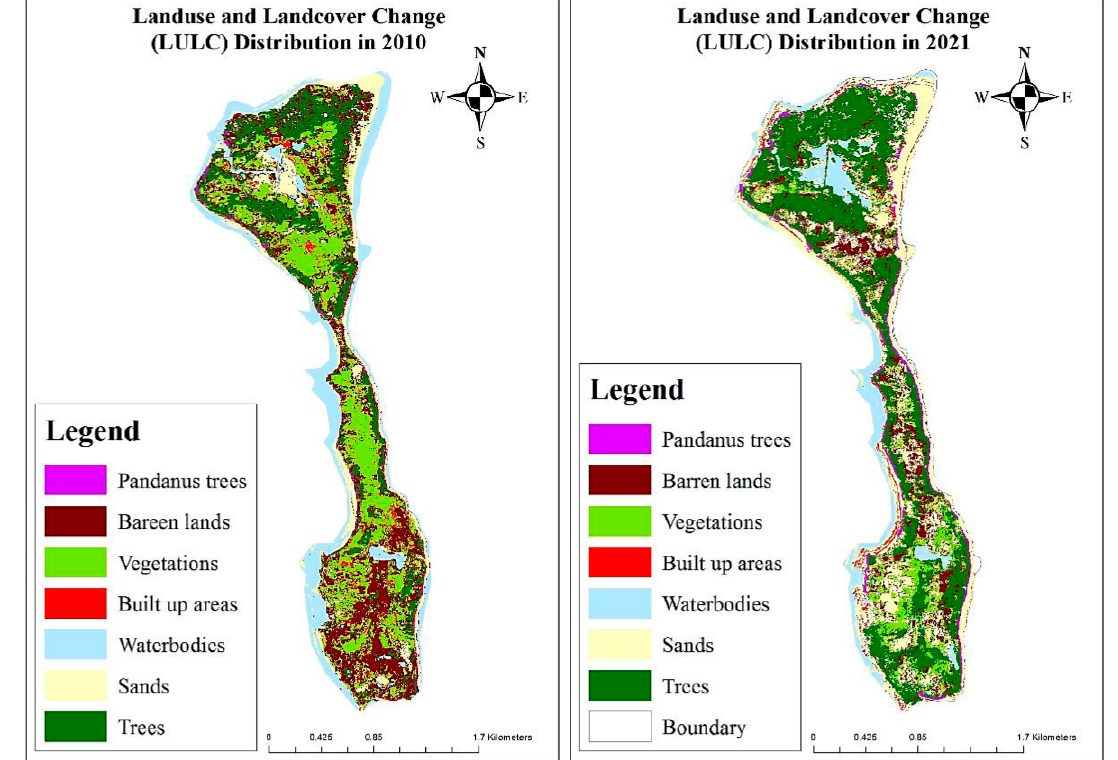
Figure 4. Land use map of Saint Martin’s Island in 2010 and 2021.